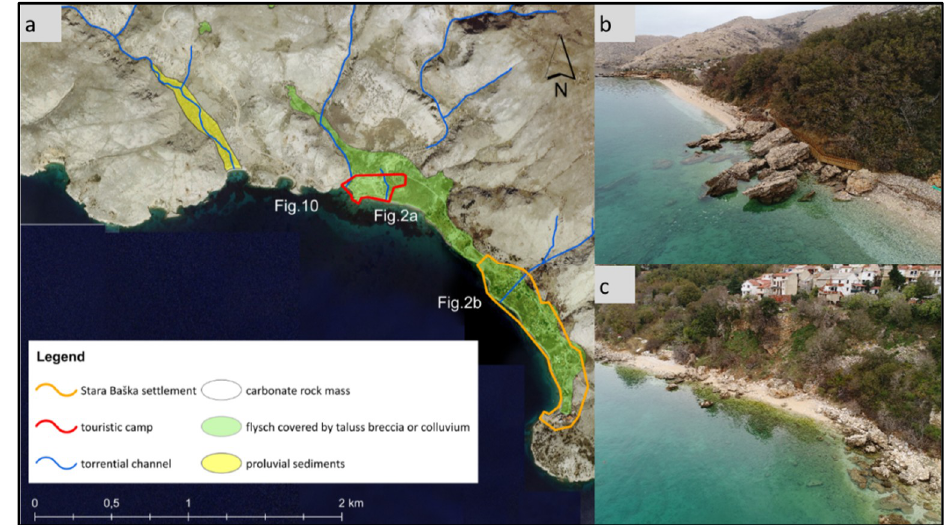
Figure 2. A simplified engineering geological map of the analyzed area.